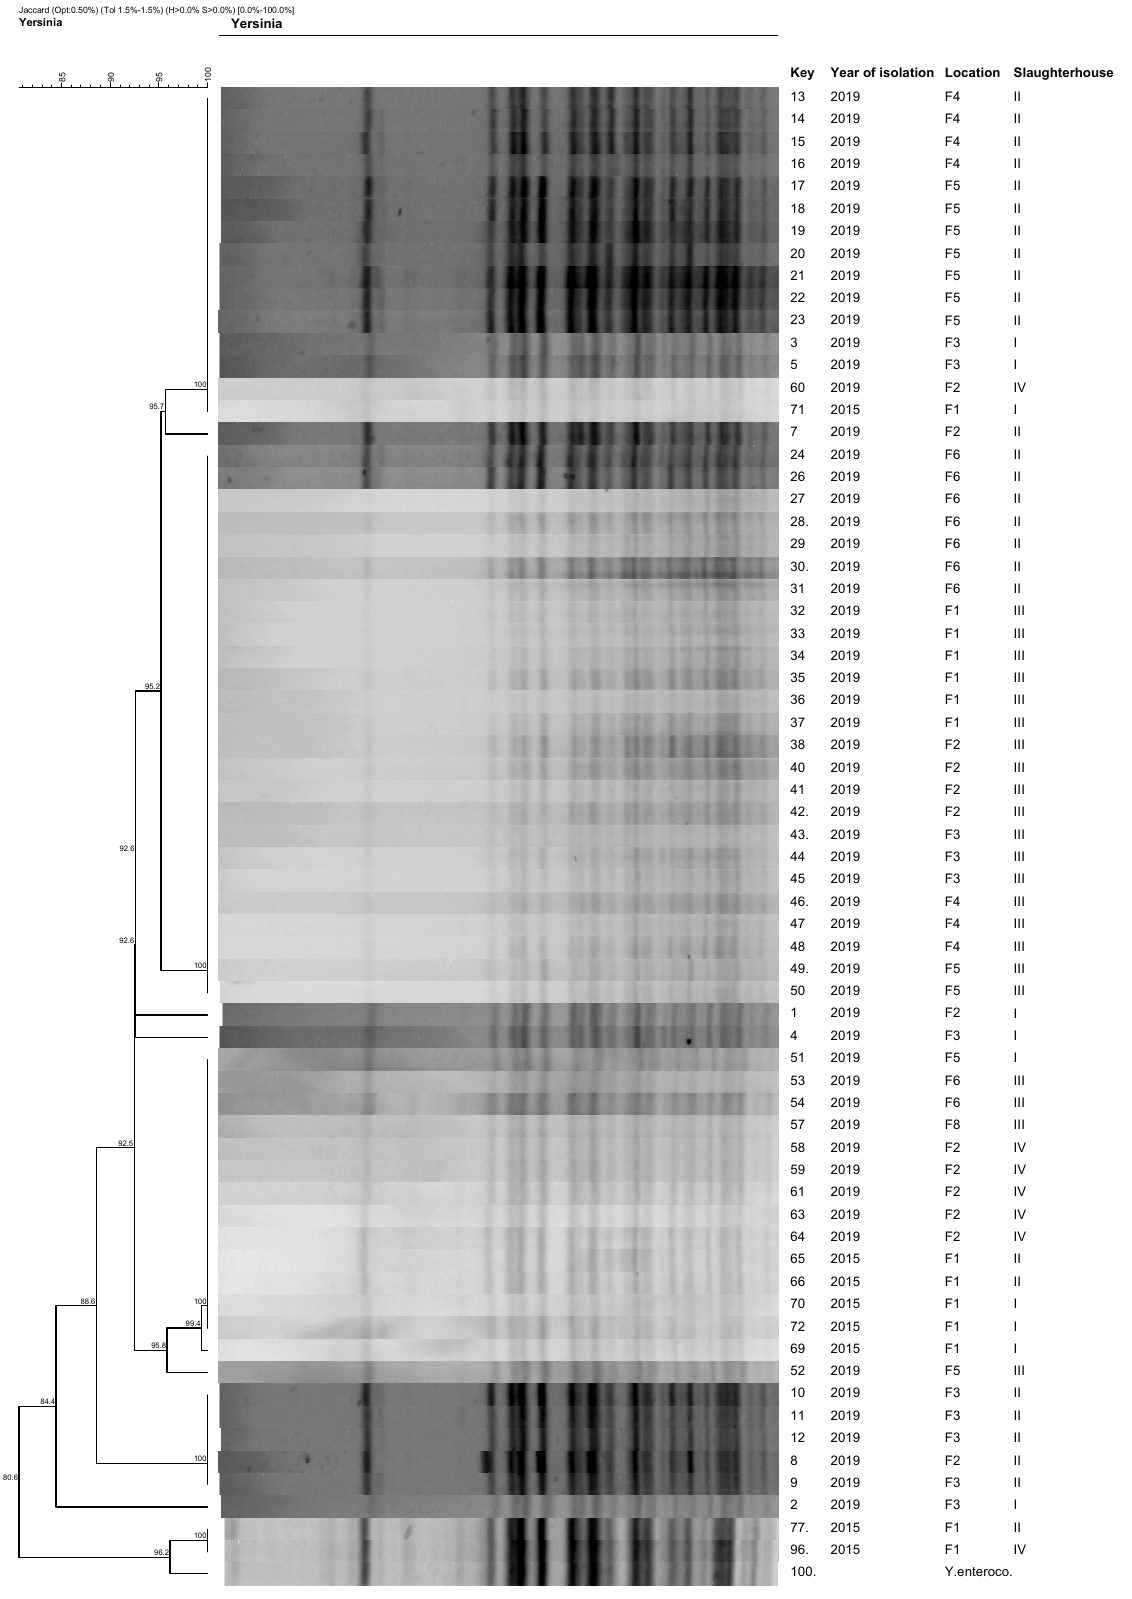
Figure 1. PFGE profiles of Y. enterocolitica 4/O:3 from different farm types, slaughterhouses, and years of isolation .